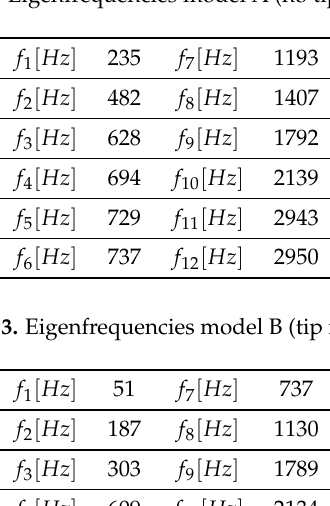
Table 2. Eigenfrequencies model A (no tip mass).